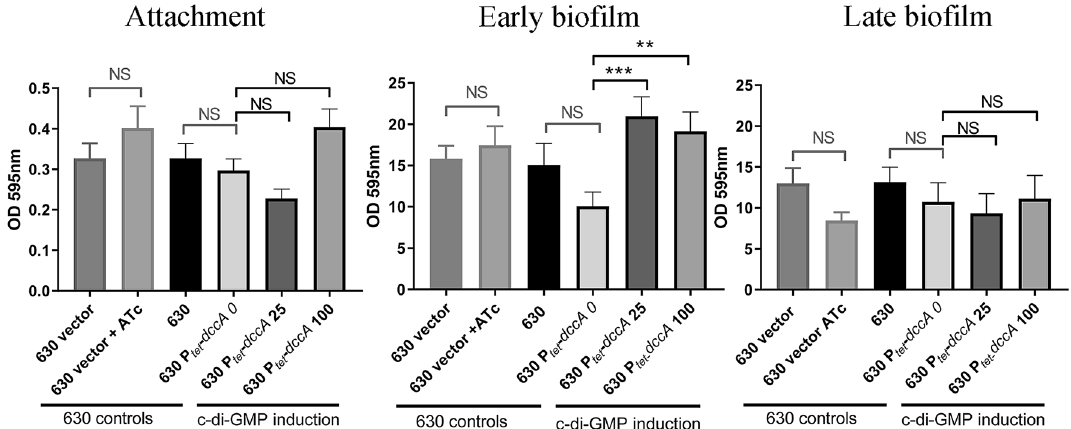
Figure 3. The effect of the secondary messenger c-di-GMP on biofilm formation for C. difficile strain 630. In-vitro attachment, early biofilm and late biofilm formation in 24 well plates were quantified using crystal violet assays with strains of C. difficile 630 containing an empty plasmid (630 vector), or with a plasmid-based diguanylate cyclase ( dccA ) under control of a P tet (inducible) promoter. These were compared to a 630 control strain containing a plasmid in the presence of 100 ng/mL anhydrotetracycline (630 vector + ATc). Biofilm and attachment assays were performed with a minimum of biological quadruplicate. The concentration of ATc used to induce dccA is listed in the graphs (0, 25 or 100 ng/mL), strain labelled 630P tet dccA 0 is an uninduced vector control. Error bars are SD. Significant differences are calculated using linear regression analysis compared to